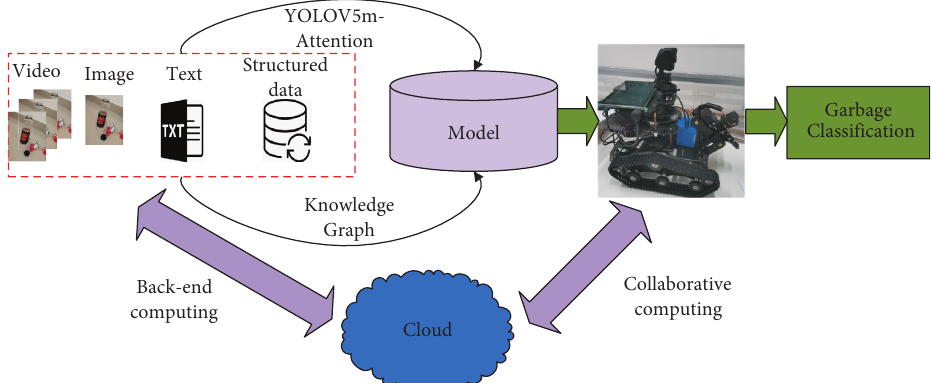
Figure 1: Overall architecture diagram.